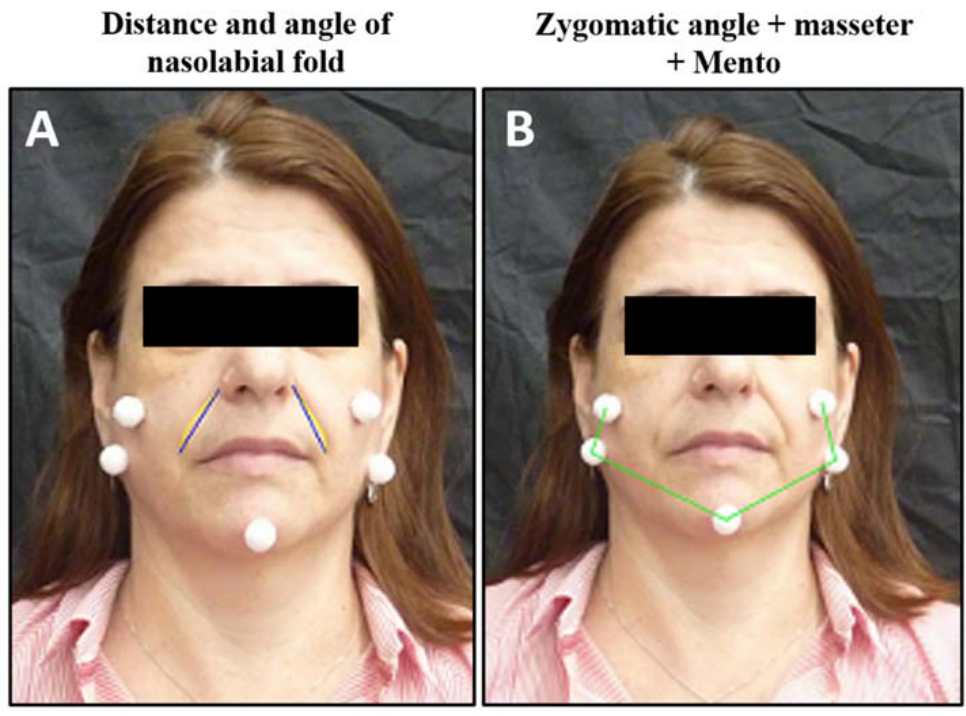
Figure 1. Representative figure showing the distance and angle of nasolabial fold ( A ) and angle between masseter and mento by the union of the zygomatic, masseter, and mento points ( B ) used for facial contour analysis and internal facial expression.